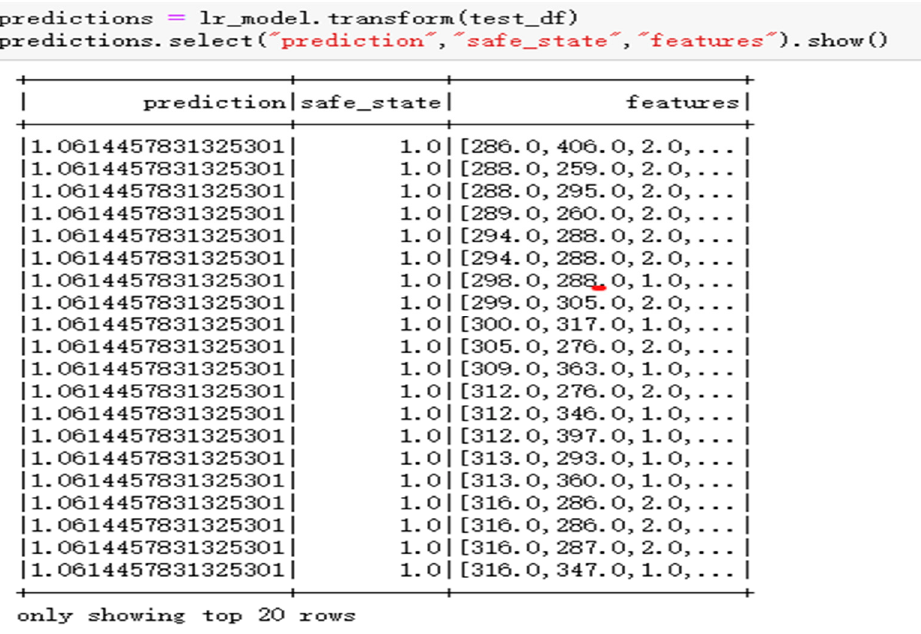
Figure 4. Predicted values for various devices.